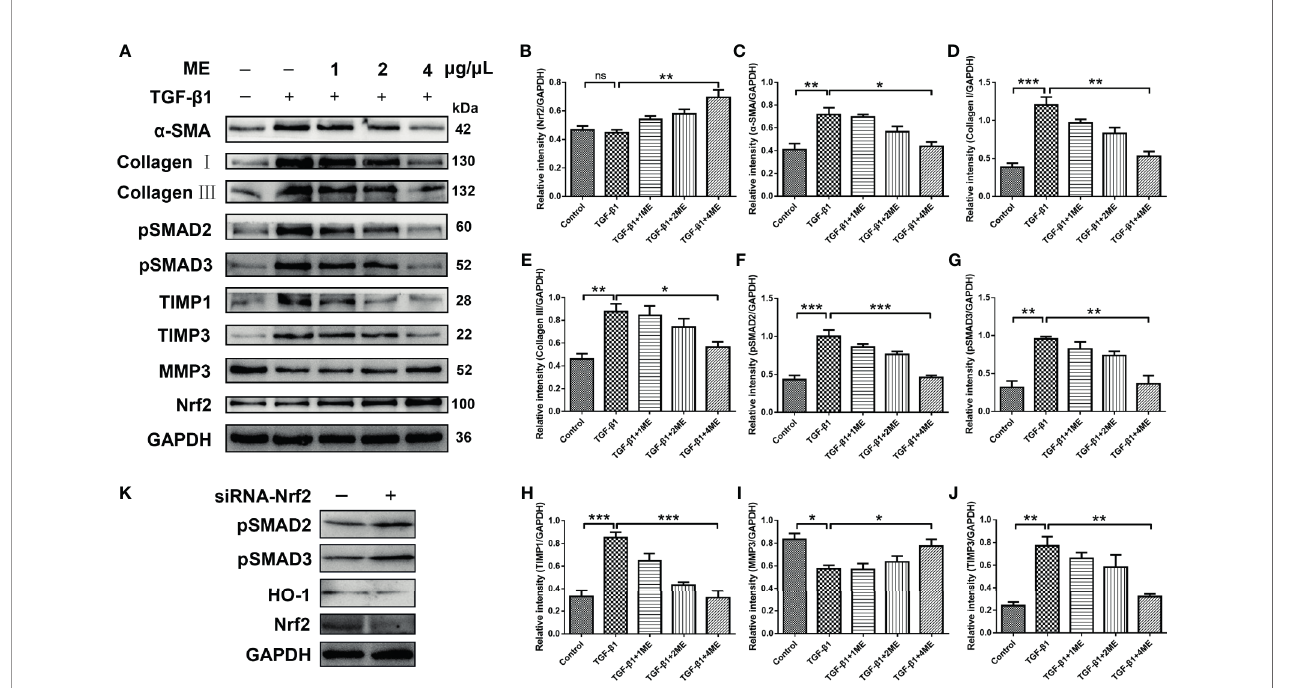
FIGURE 5 | ME suppresses the expression levels of fi brosis markers in TGF- b 1-stimulated CCD-18Co cells. (A) TGF- b 1-stimulated CCD-18Co cells were treated with ME for 8 h at different doses, and the protein levels of Nrf2 and fi brosis markers were detected and normalized to GAPDH. (B – J) Western blot bands were analyzed by densitometry. (K) SMADs signaling were detected by silencing Nrf2 without exogenous TGF- b . Data are presented as mean ± SD. ∗ P < 0.05, ∗∗ P < 0.01, and ∗∗∗ P < 0.001; ns, no signi fi